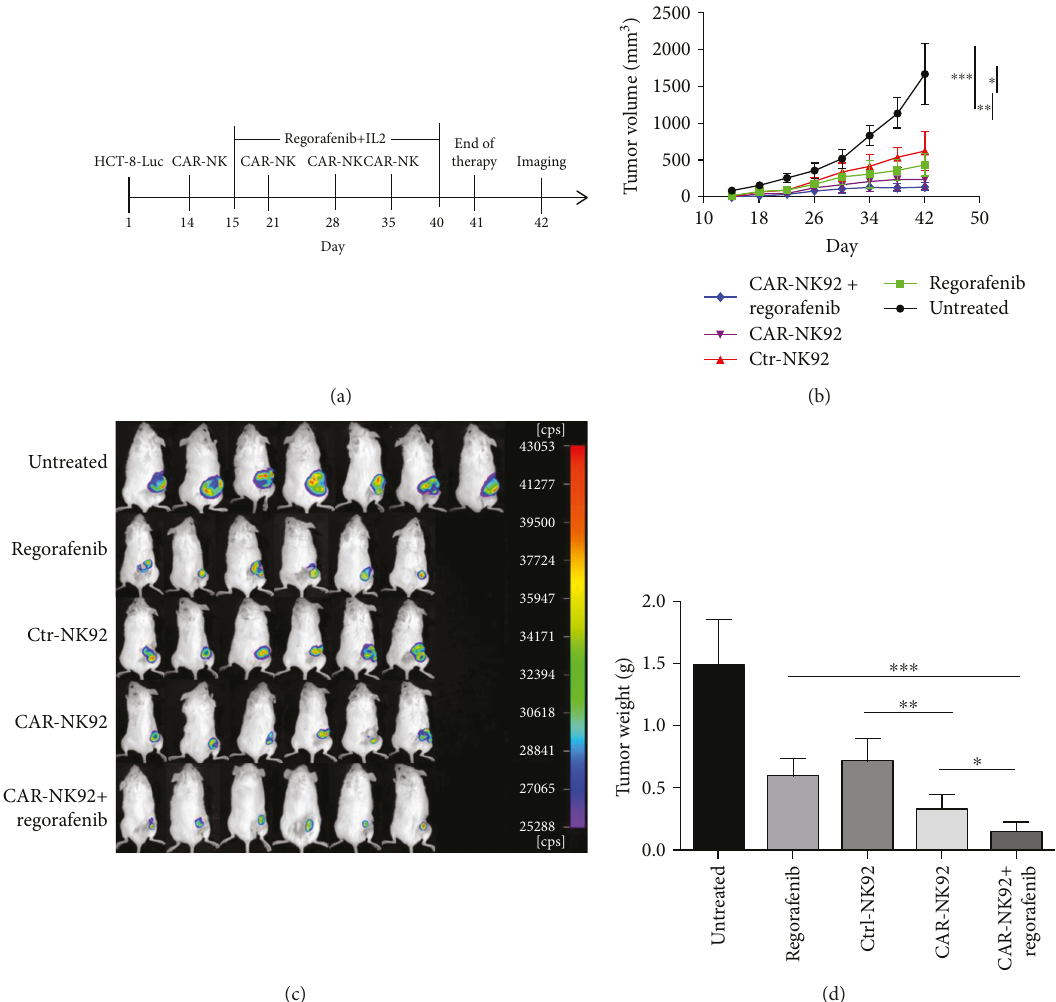
Figure 4: Therapeutic e ffi cacy of EpCAM-speci fi c CAR-NK-92 cells combined with regorafenib for human colorectal cancer xenografts established with HCT-8 cells. (a) Schematic diagram showing the treatment program of the mice. (b) The tumor growth curves during the experiment. (c) Luminescence images showing the tumor size at the end of the treatment. (d) Tumor weight at the end of treatment. ∗ p < 0 05 ; ∗∗ p < 0 01 ; ∗∗∗ p < 0 001